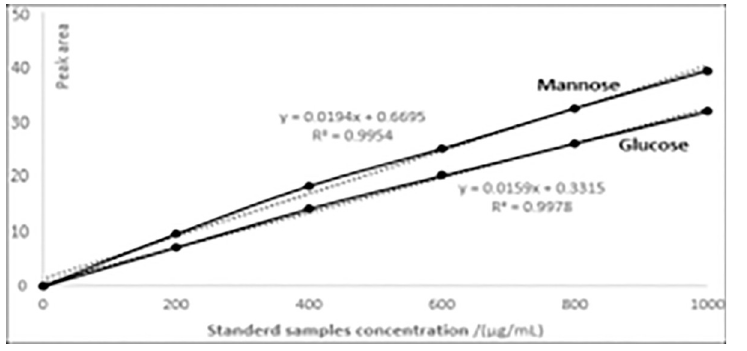
Fig 8. Standard curve of glucose and mannose.